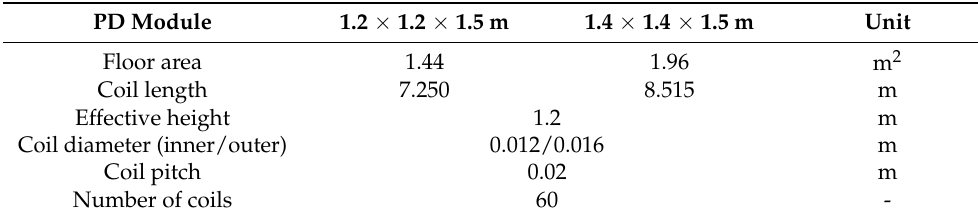
Table 2. Specification of the prototype module pertaining to the HX container.